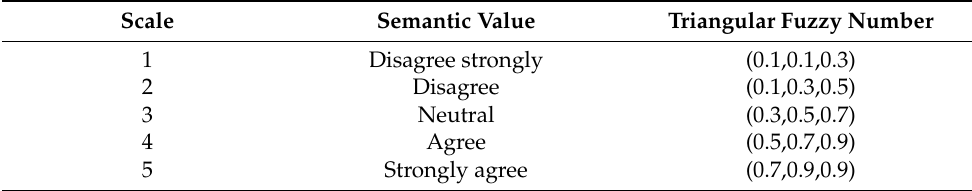
Table 7. Fuzzy semantics scale comparing relative